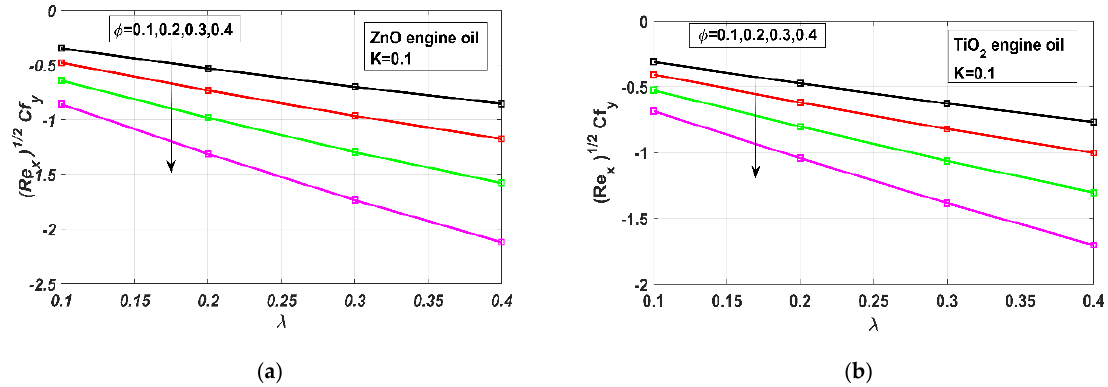
Figure 6. The impact of rotation parameter λ ( a , b ) on skin friction along the x -axis.